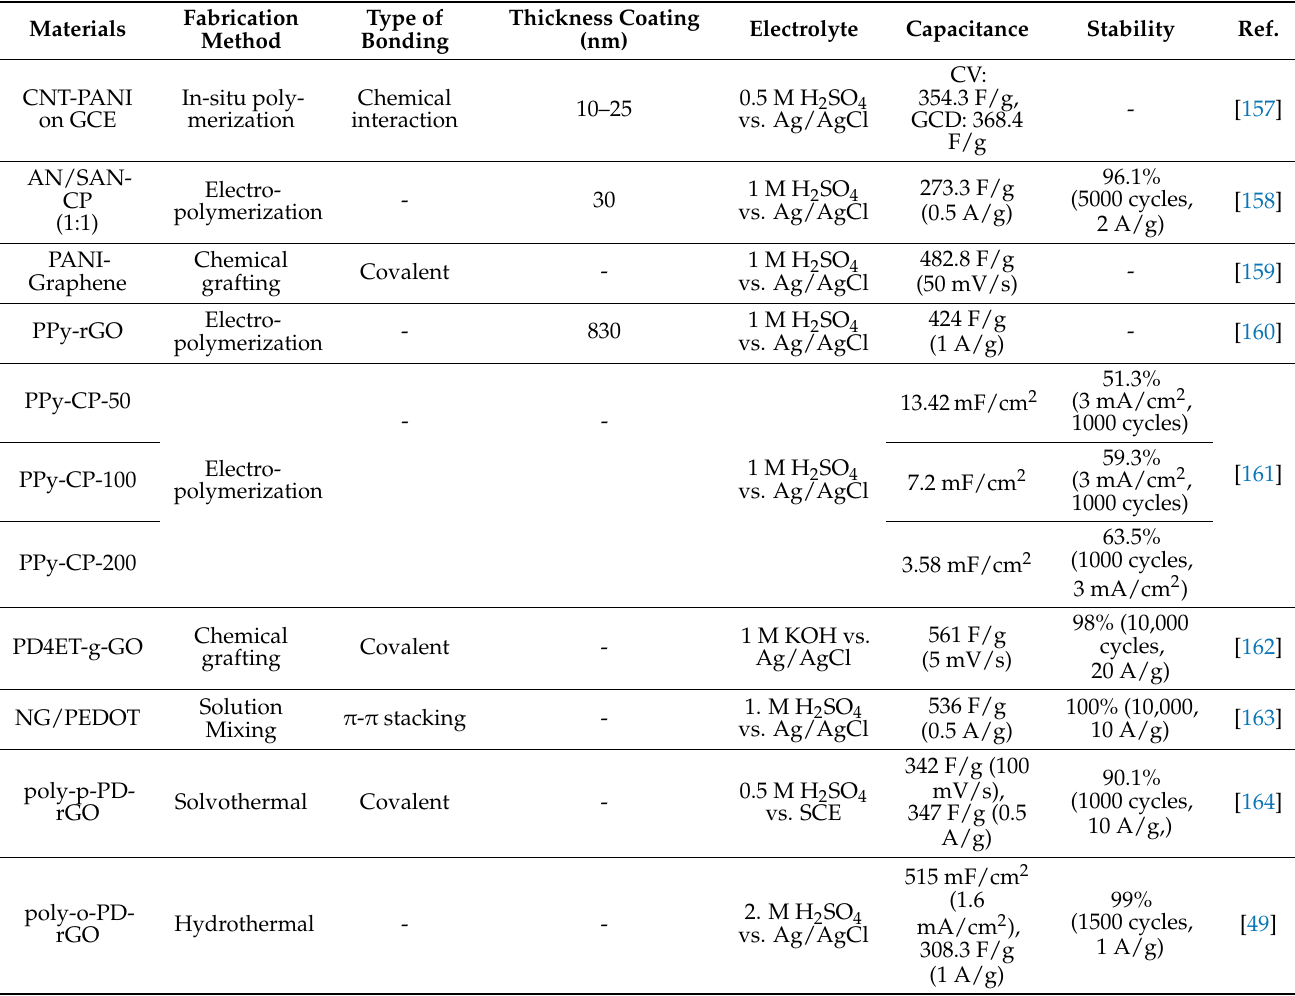
Table 2. Comparison of fabrication methods, bonding type, thickness, and electrochemical performance for some redox active polymers and small molecules deposited on CNT, graphene and activated carbon. Fabrication Materials